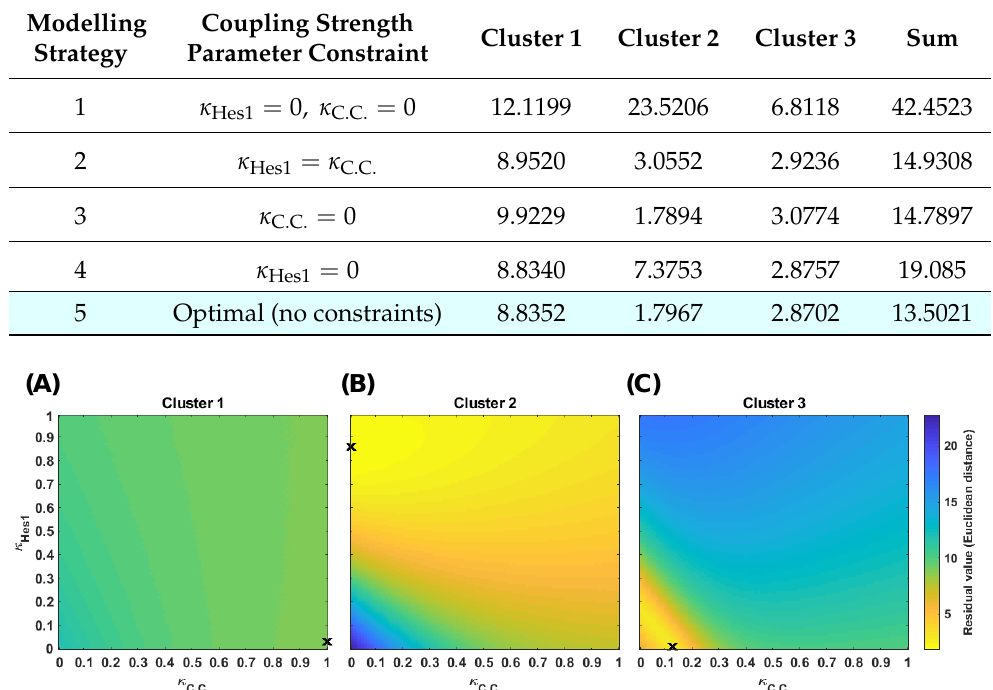
Table 1. Table of residual comparisons for each modelling strategy 1 to 5. Values are the minimised R values found by fitting the pseudo-timed model solution θ given parameter constraints. Highlighted in cyan is the strategy with the lowest summed residuals across clusters.